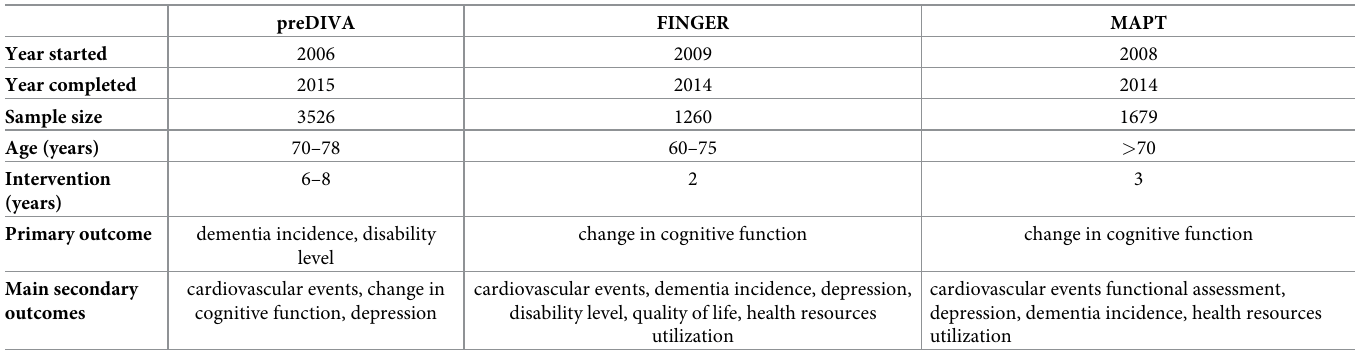
Table 1. Main study characteristics of pooled